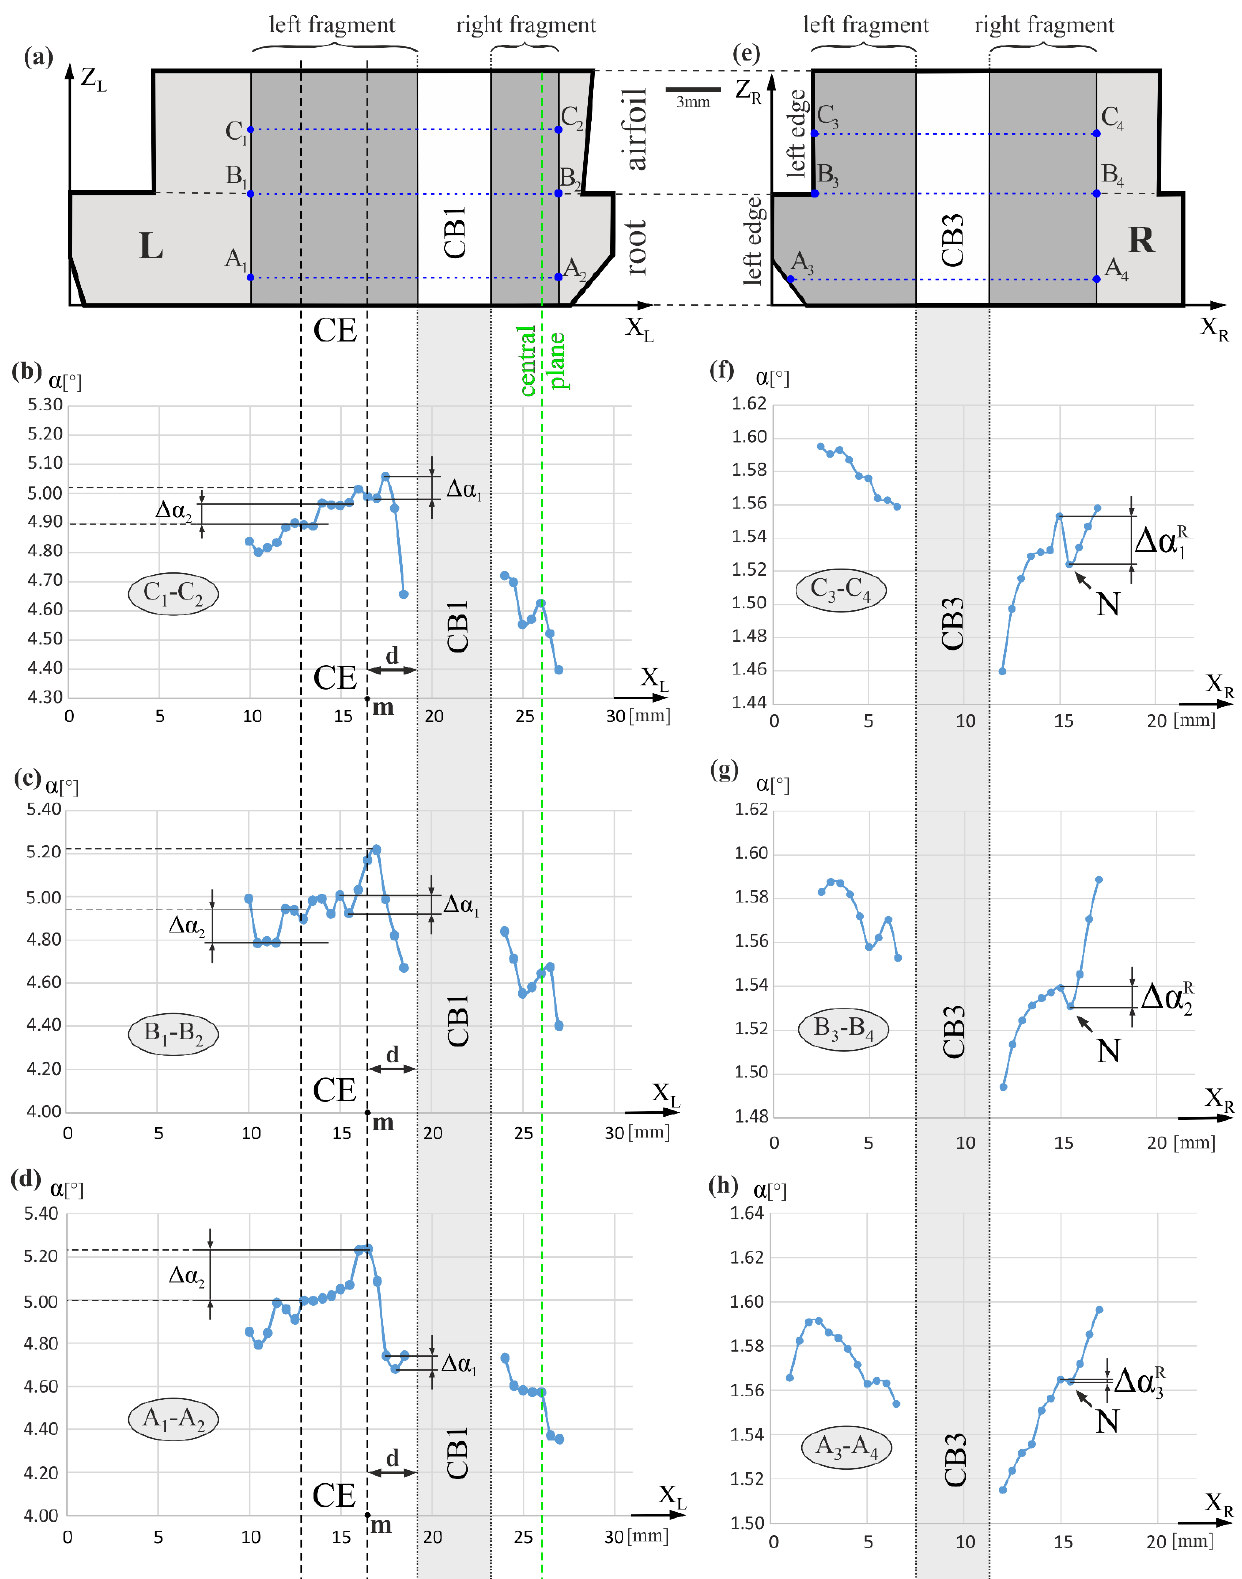
Figure 3. Scheme of the arrangement of the α angle measurement lines ( a , e ) and the α angle values distribution in the fragments L ( a – d ) and R ( e – h ) surfaces along these lines perpendicular to the axes X L , X R , and blade axis Z, as well as, perpendicular to the sidewall of CB1 and CB3 cooling bores in their vicinity. For simplicity, the labels of the measurement axes are replaced by parallel axes X L and X R